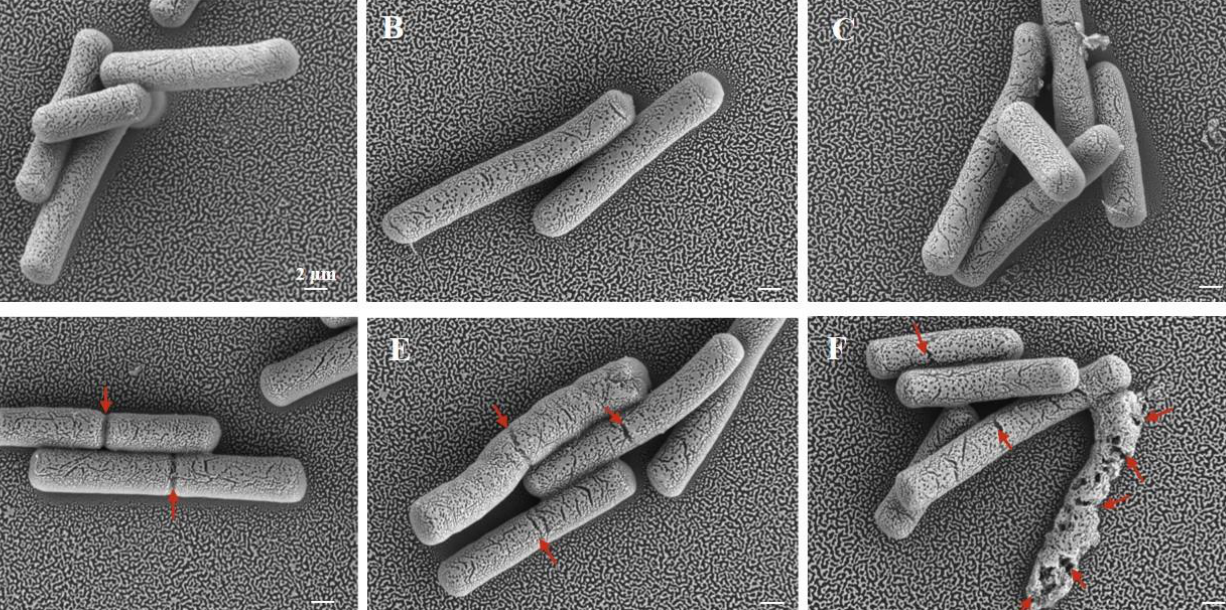
Figure 4. Transmission electron microscope image of B. subtilis after PDT treatment. ( A ) Untreated group; ( B ) single LED light group; ( C ) single 50 μmol/L curcumin group; ( D ) The treatment with 10 μmol/L curcumin for the illumination time of 12 min; ( E ) The treatment with 30 μmol/L curcumin for the illumination time of 12 min; ( F ) The treatment with 50 μmol /L curcumin for the illumination